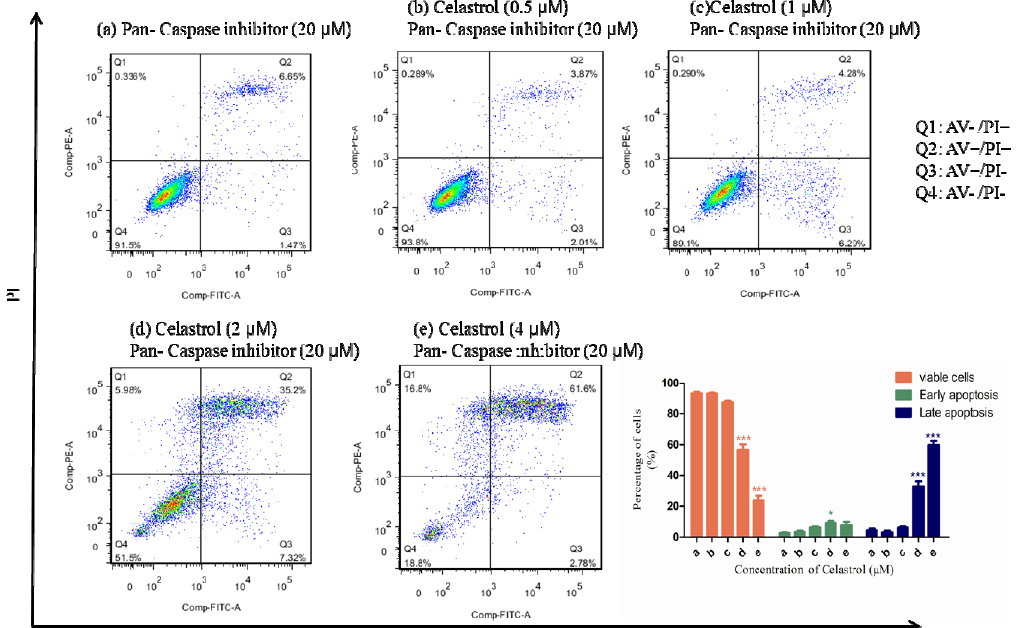
Figure 5. Compared with the celastrol single treatment group, the pretreatment of pan- caspase inhibitor can partially attenuate the apoptotic effect induced by celastrol in